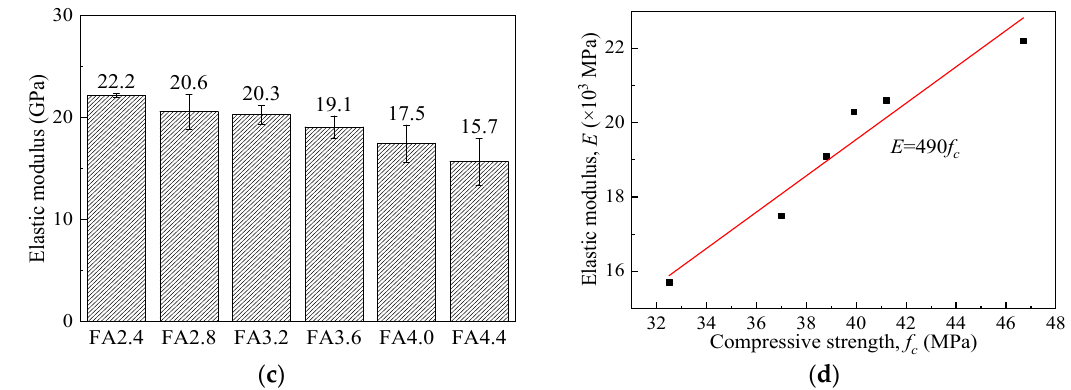
Figure 8. Comparison of the compressive behavior of the mixes. ( a ) Compressive strength; ( b ) peak compressive strain; ( c ) elastic modulus; ( d ) correlation between compressive strength and elastic modulus.